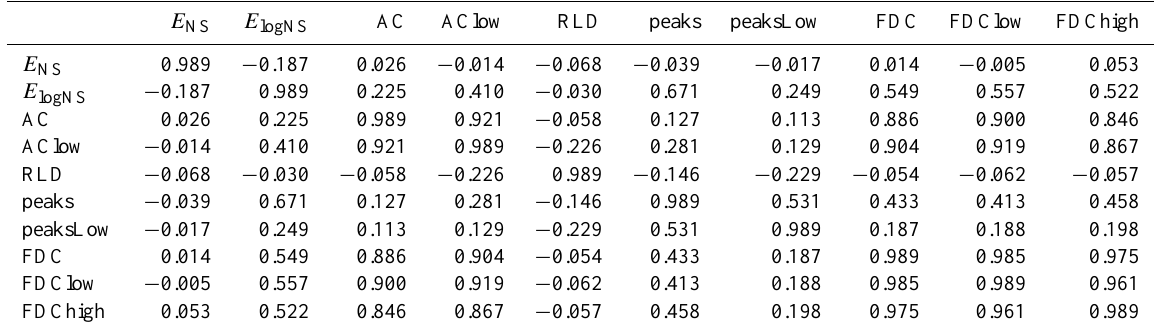
Table 5. Covariance matrix of the evaluation criteria for M8 in the Maimai catchment. The data are normally transformed, and therefore the variances within a evaluation criterion are very high. However, a small experiment shows that this does not influence the PCA results a